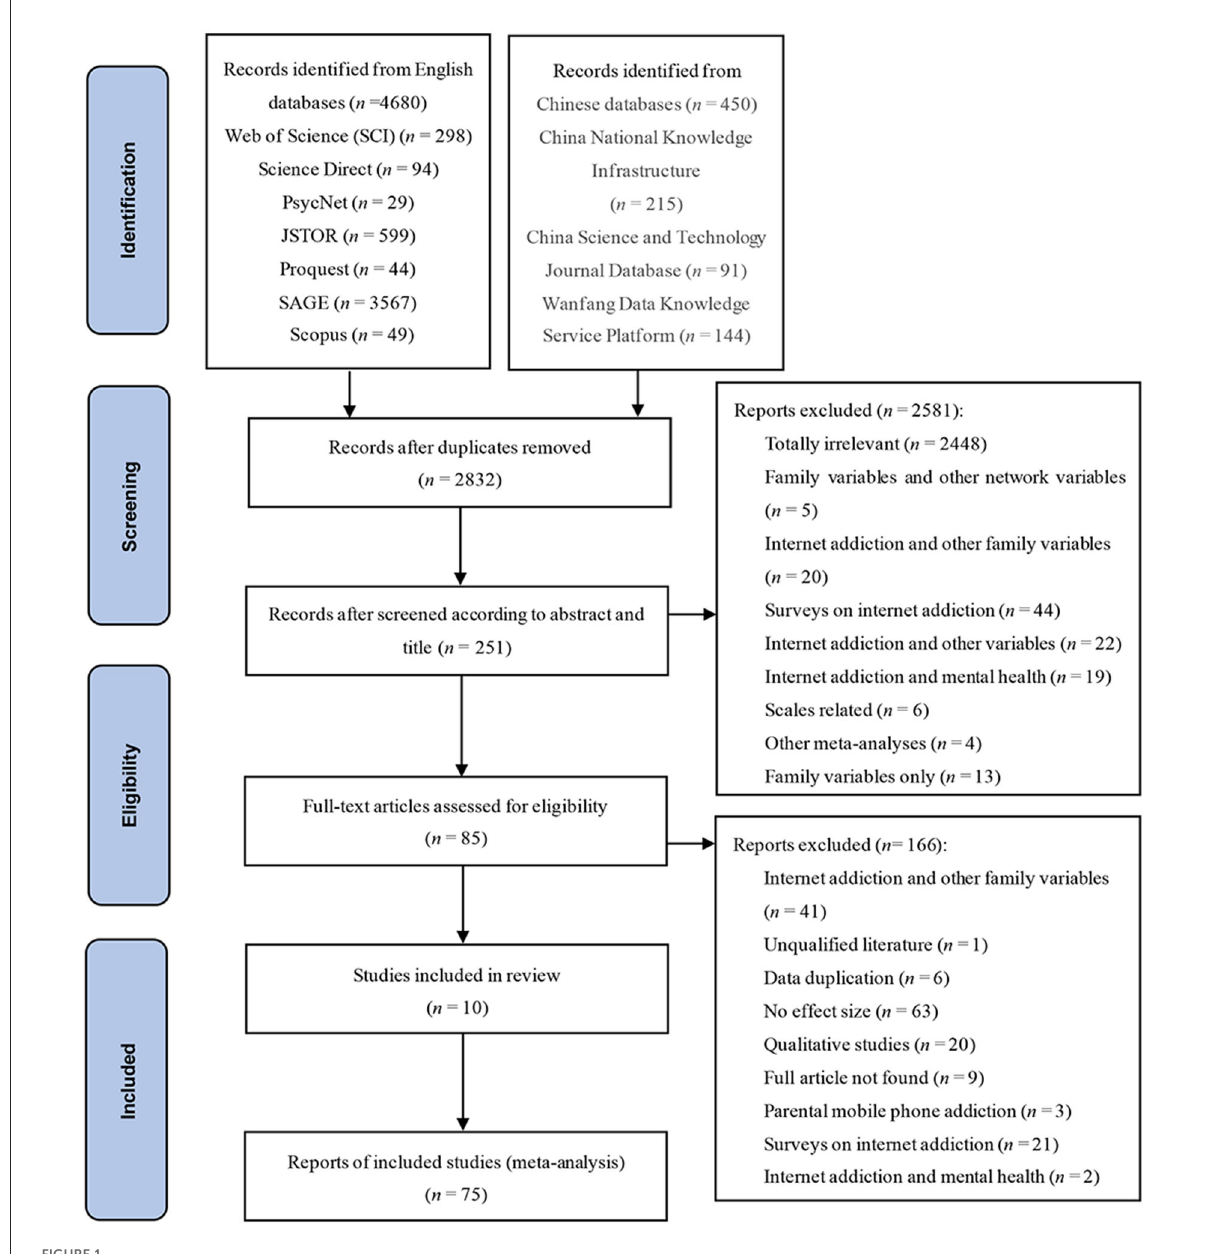
FIGURE1 PIRSMA 2009 flow